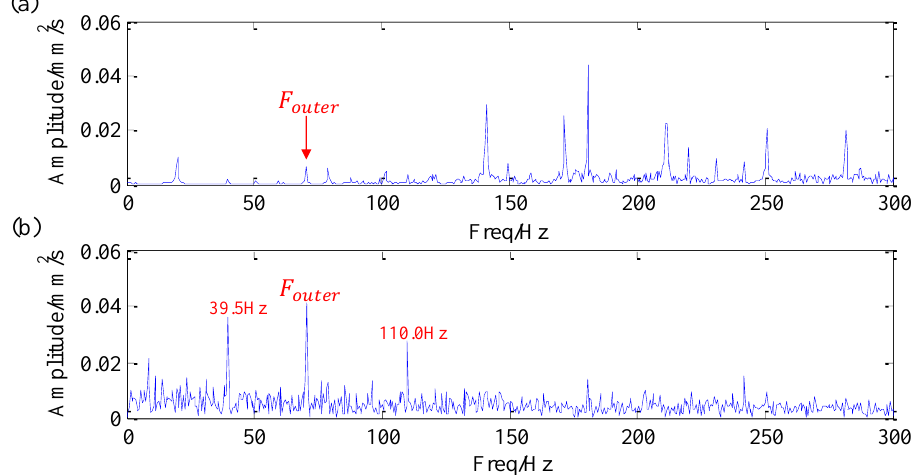
Figure 15. Filtered signal using waveform denoising: ( a ) frequency spectrum and ( b ) envelope spec- trum.